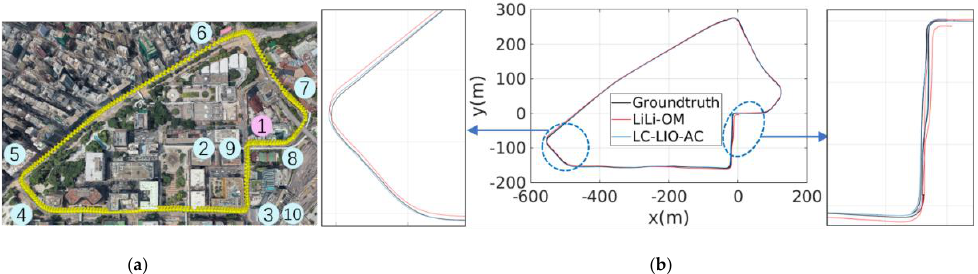
Figure 13. The trajectory of the dataset collected in the urban canyon 2: HK-Data20190428. ( a ) The ground truth aligned on Google Earth from the bird-eye view. The first marked place is the start point. The other ten marked places are the nine turns. ( b ) Trajectory comparison, the black trajectory is ground truth, and the red and blue trajectories are estimated by LiLi-OM and LC-LIO-AC, respectively.